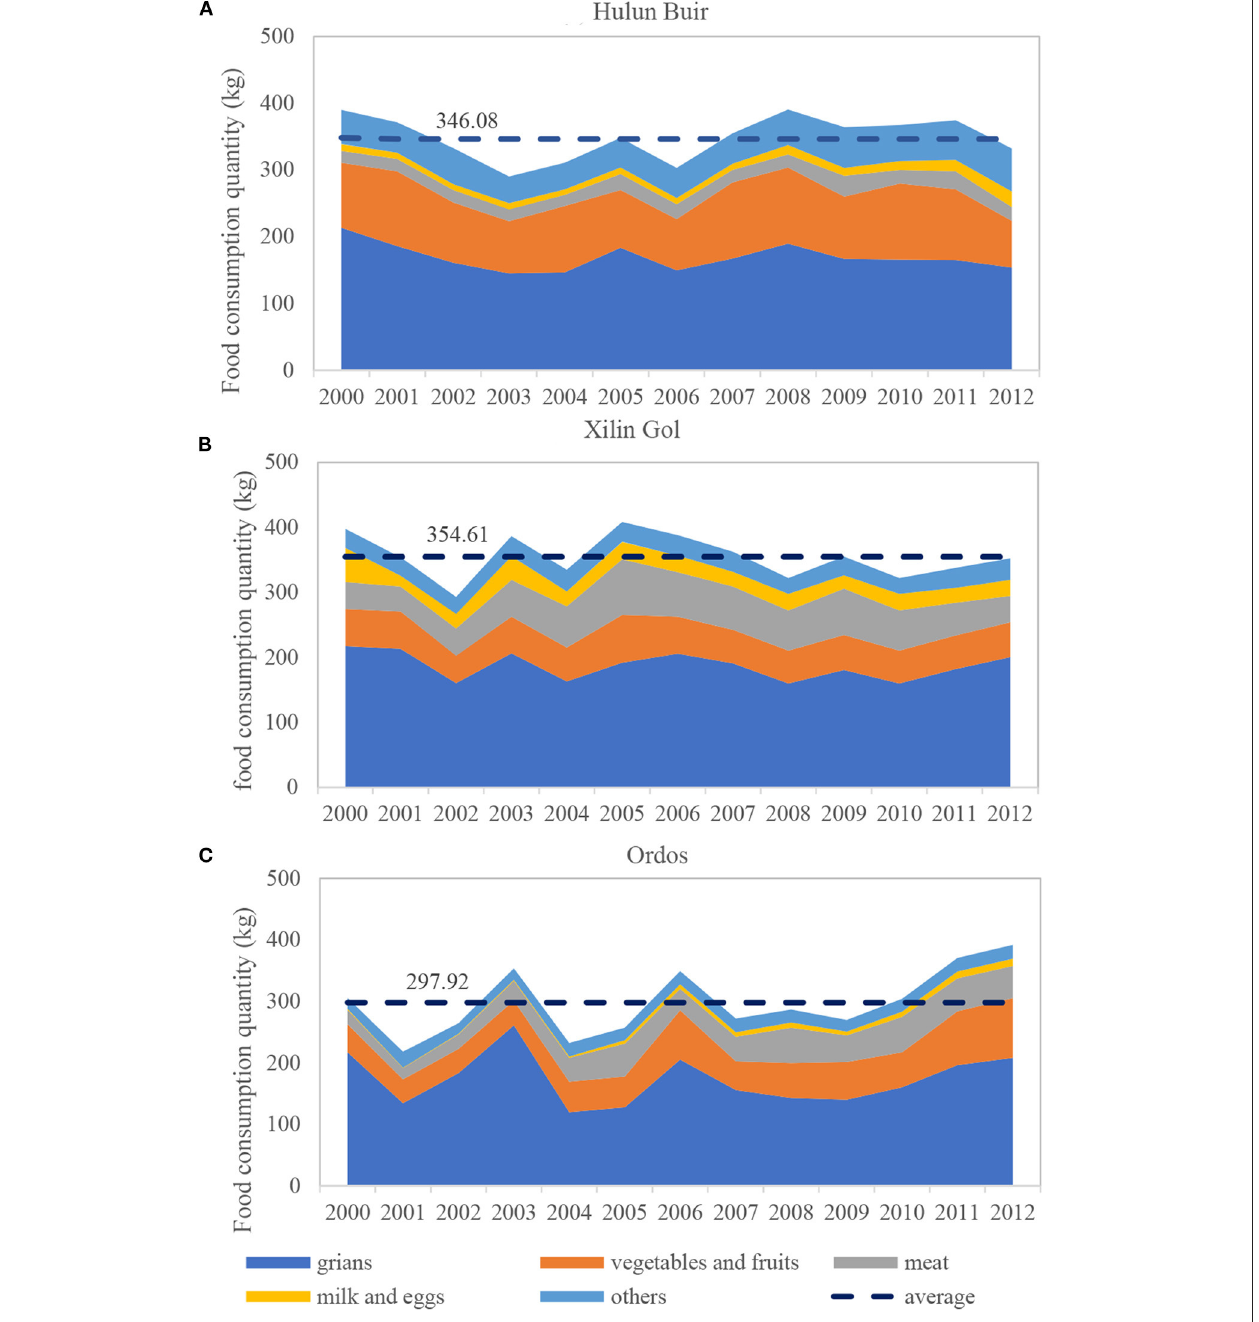
FIGURE 2 | The food consumption structure of residents (2000–2012). Data source: Statistical yearbooks from 2000 to 2012 that were assorted and calculated by the authors of this study. (A) Hulun Buir, (B) Xilin Gol, (C) Ordos.